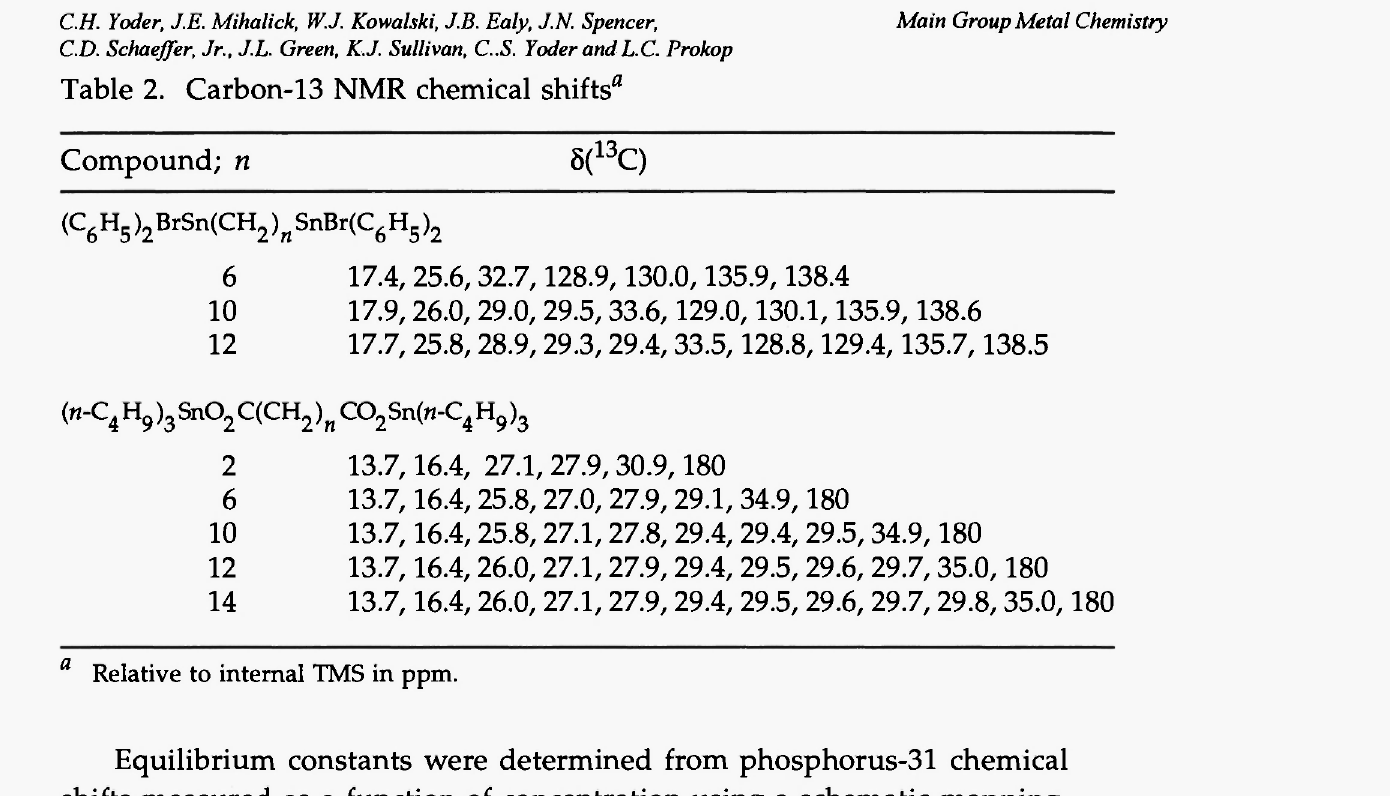
Table 2. Carbon-13 NMR chemical shifts 0